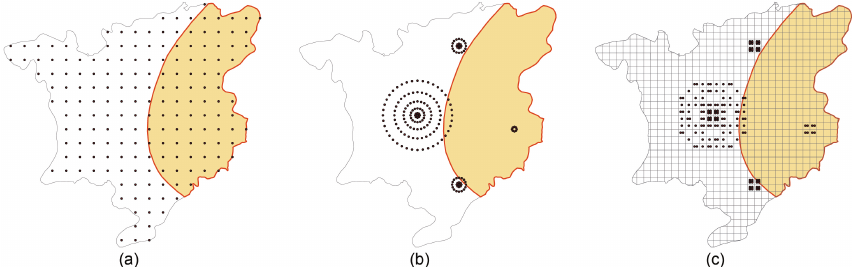
Figure 8. The representation of the spatial distribution of population exposure data. The points represent the population distribution. The area surrounded by the red boarder represents the affected disaster area within an administration unit. (a) Average distribution inside the whole administration unit; (b) actual distribution according to settlements; (c) gridded distribution supported by the dasymetric map